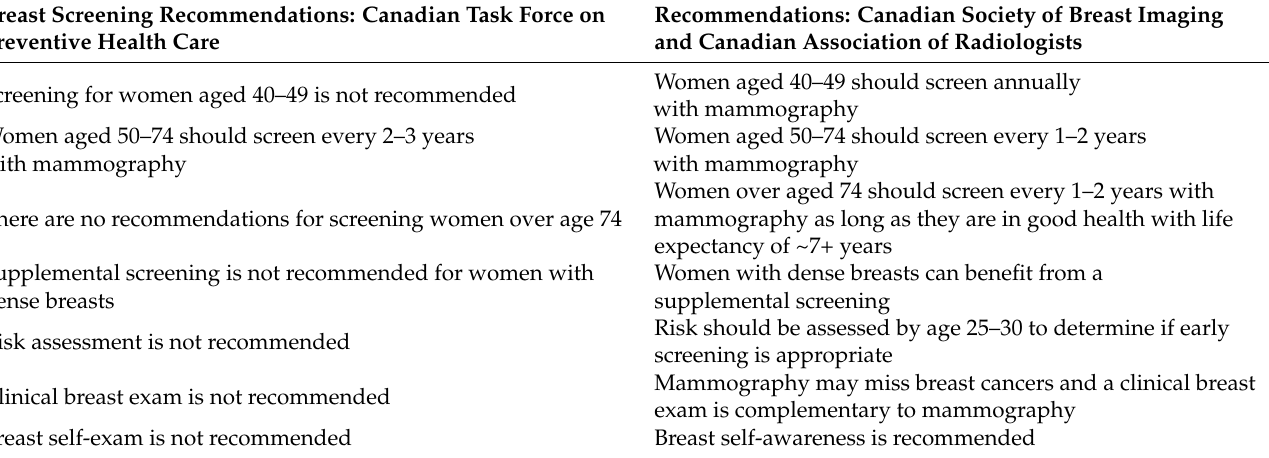
Table 2. Comparison of breast screening recommendations from The Canadian Task Force on Preventive Health Care [7] and the Canadian Society of Breast Imaging recommendations [27]. Recommendations: Canadian Society of Breast